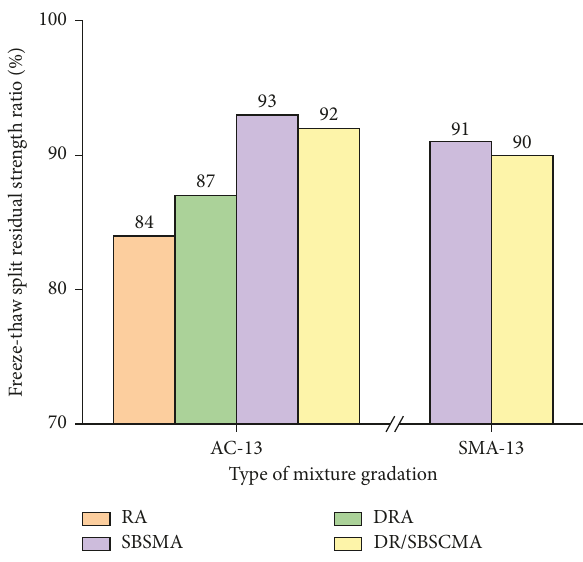
Figure 16: Results of the freeze-thaw splitting test of